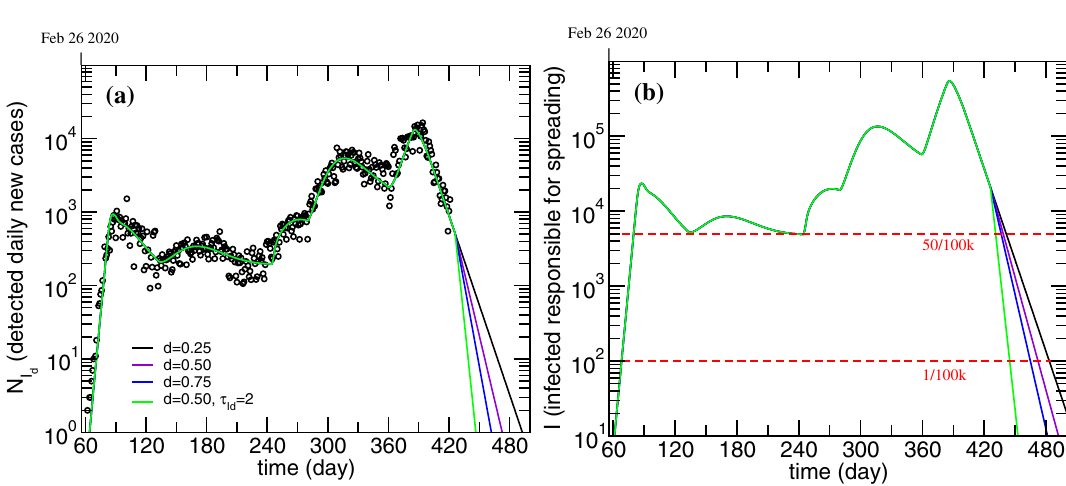
Figure 5. Evolution of the detected daily new cases ( a ) and infected non-isolated, responsible for spreading the disease ( b ). Effect of different values of d keeping τ Id equal to 6.25 days and effect of increasing d to 0.5 while decreasing τ Id to 2 days. The parameters were changed only after March